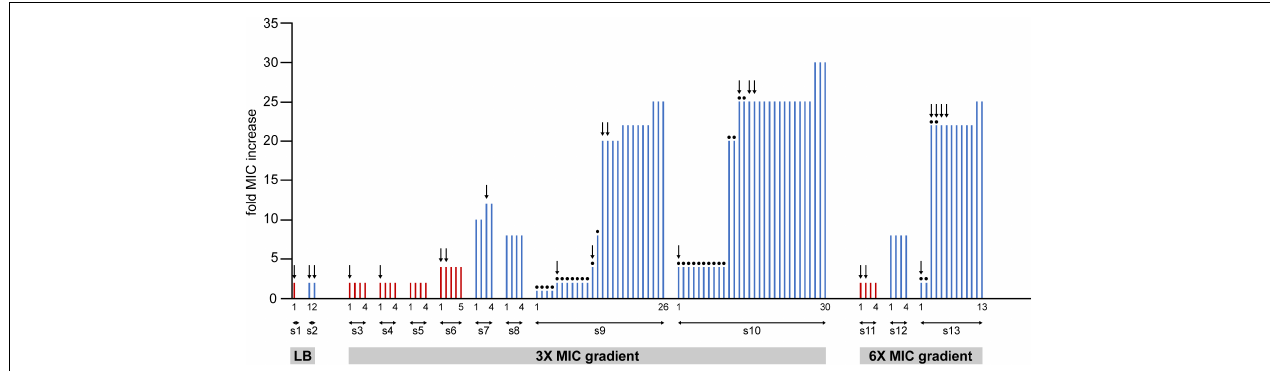
FIGURE 3 | Summary of the measured changes in the MIC values of clones isolated from samples of 13 independent experiments (from s1 to s13). Cells from frozen stocks of samples collected from the microfluidic devices were cultured overnight and spread on agar plates. Bars represent MIC values measured on colonies grown on these plates. Red and blue bars represent samples from 48 to 72 h long experiments, respectively. Dots on top of bars designate colonies grown from cultures that were enriched in LB without ciprofloxacin after cells were picked from the frozen stocks. In other cases (no dots) enrichment was done in LB containing 16 ng/ml (1 × MIC) ciprofloxacin. Colonies from each experiment are numbered, the first and the last ones are labeled on the figure.